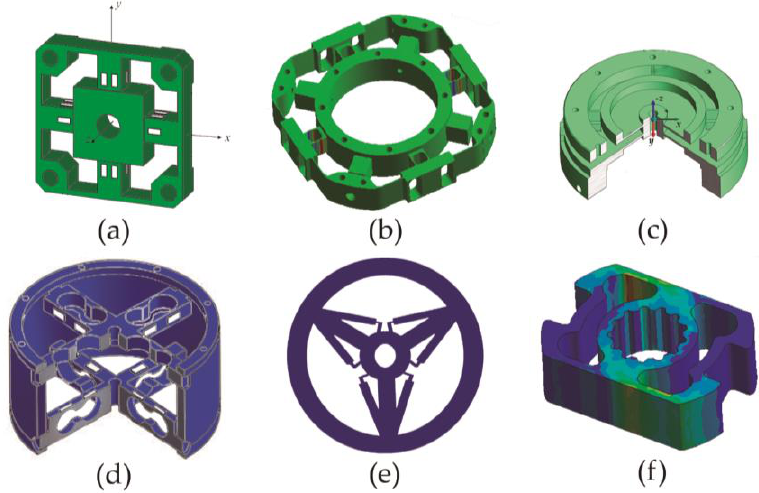
Figure 2. Types of force/torque sensor structures: ( a ) Crossbeam, ( b ) Crossbeam modified, ( c ) Body E-type membrane (EE) ( d ) Sliding structure, ( e ) Four-bar linkage shape, ( f ) Square cube.